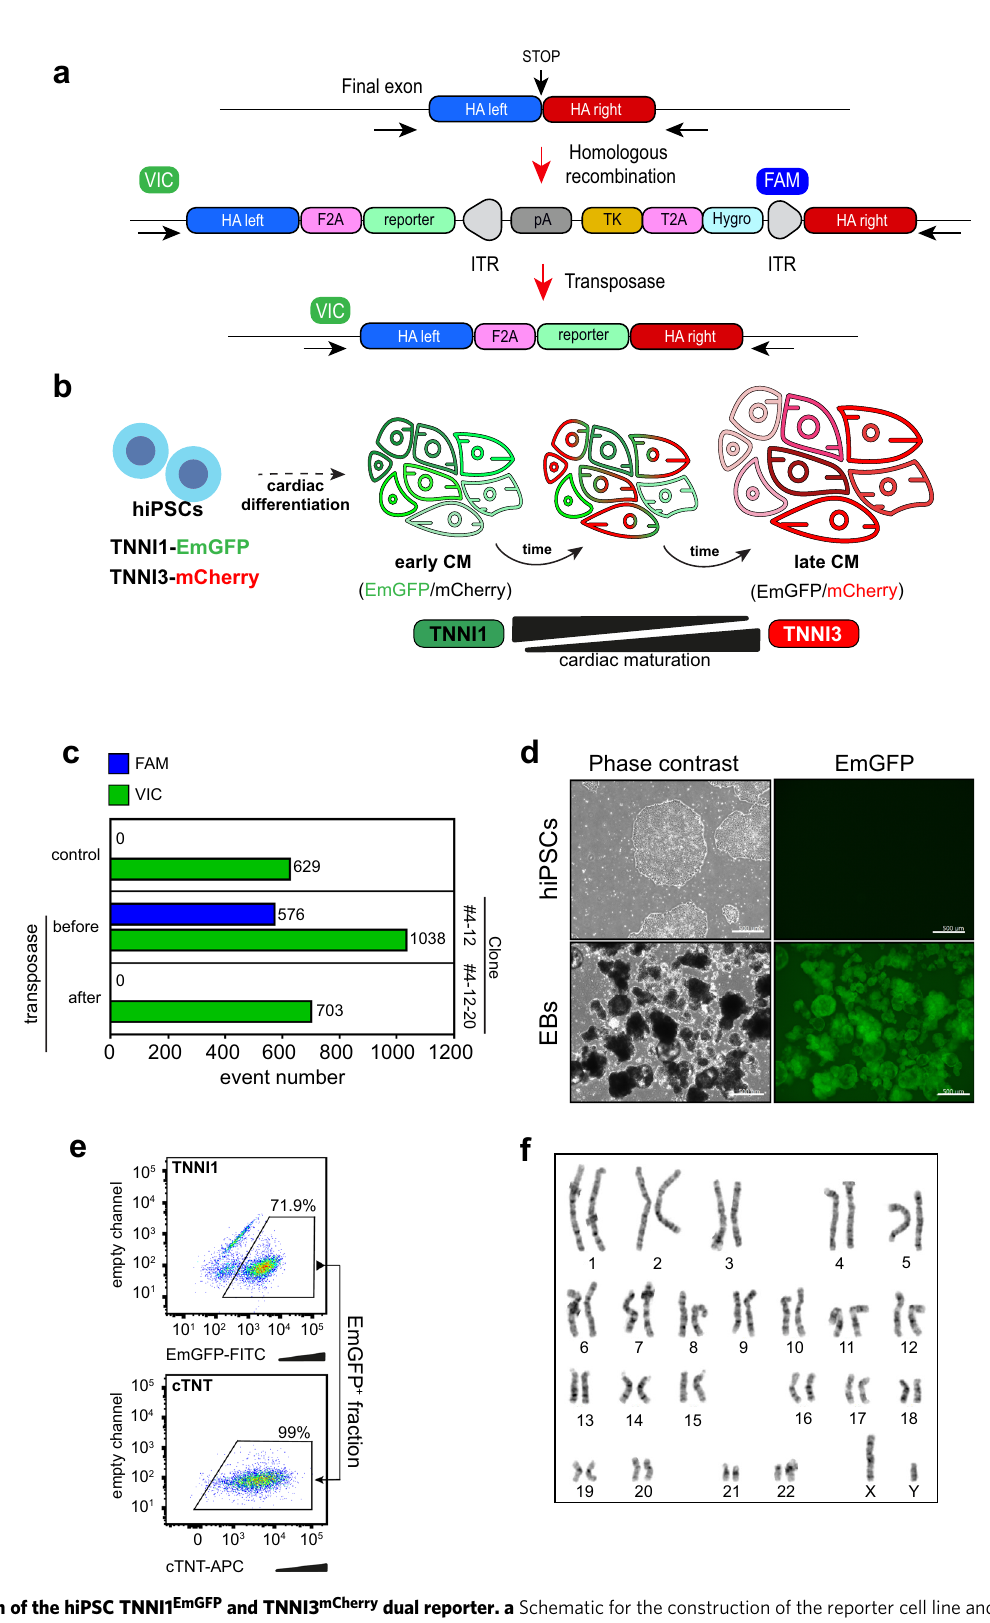
Fig. 1 Generation of the hiPSC TNNI1 EmGFP and TNNI3 mCherry dual reporter. a Schematic for the construction of the reporter cell line and the homologous recombination strategy using the CRISPR/Cas9 system. FAM (6-carboxy fl uorescein) and VIC (VIC ™ fl uorescent dye) are fl uorescent probes for ddPCR. b Schematic representation of the TNNI1 EmGFP and TNNI3 mCherry dual reporter during cardiac differentiation. c ddPCR (FAM probe, blue bars; VIC probe, green bars) of TNNI1 EmGFP knock-in clones before and after treatment with piggyBac transposase. d Phase-contrast and EmGFP fl uorescence images of hiPSCs (#4-12-20) and day-14 EBs. Scale bars: 500 μ m. e Flow cytometric analysis and sorting on day 14 of the differentiation for EmGFP + cells (top) and the EmGFP + -derived cTNT + cell fraction (bottom). f Karyotype of the generated TNNI1-EmGFP knockin clone